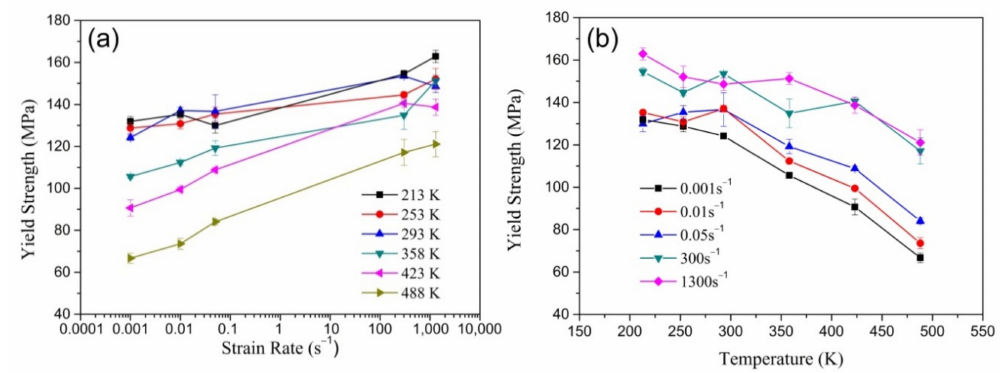
Figure 5. E ff ects of ( a ) strain rate and ( b ) temperature on the values of yield